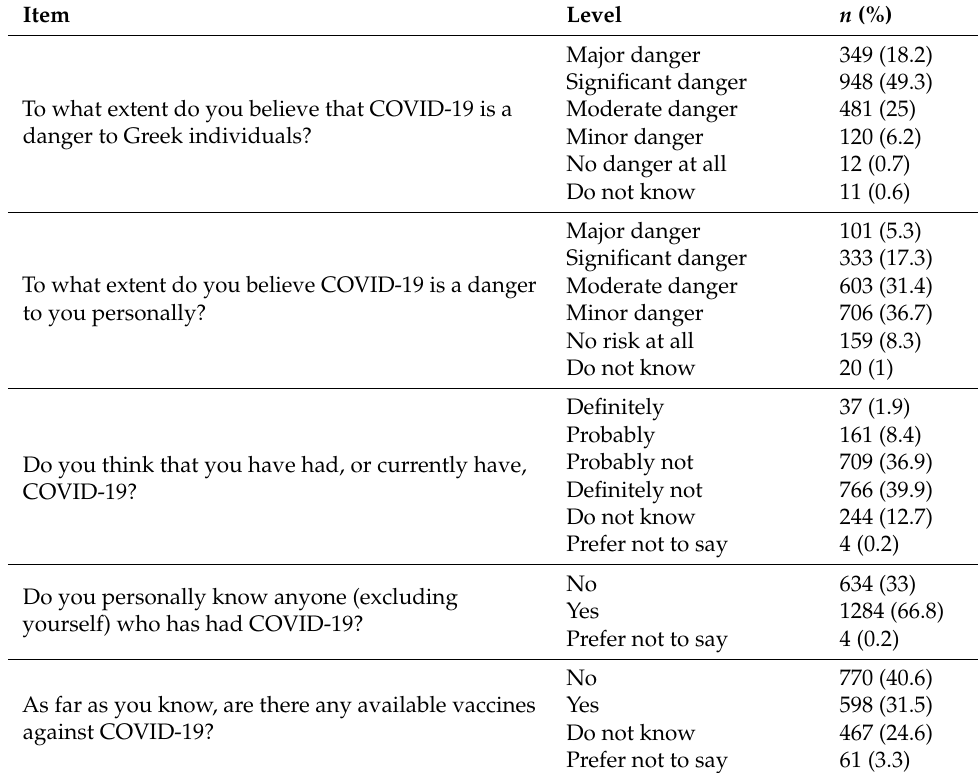
Table 2. Respondents’ perceptions about coronavirus.